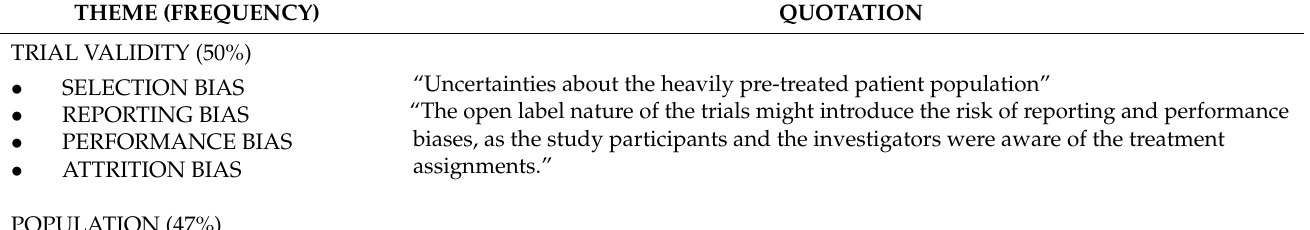
Table 2. Illustrative quotes for themes on sources of uncertainty identified in pCODR